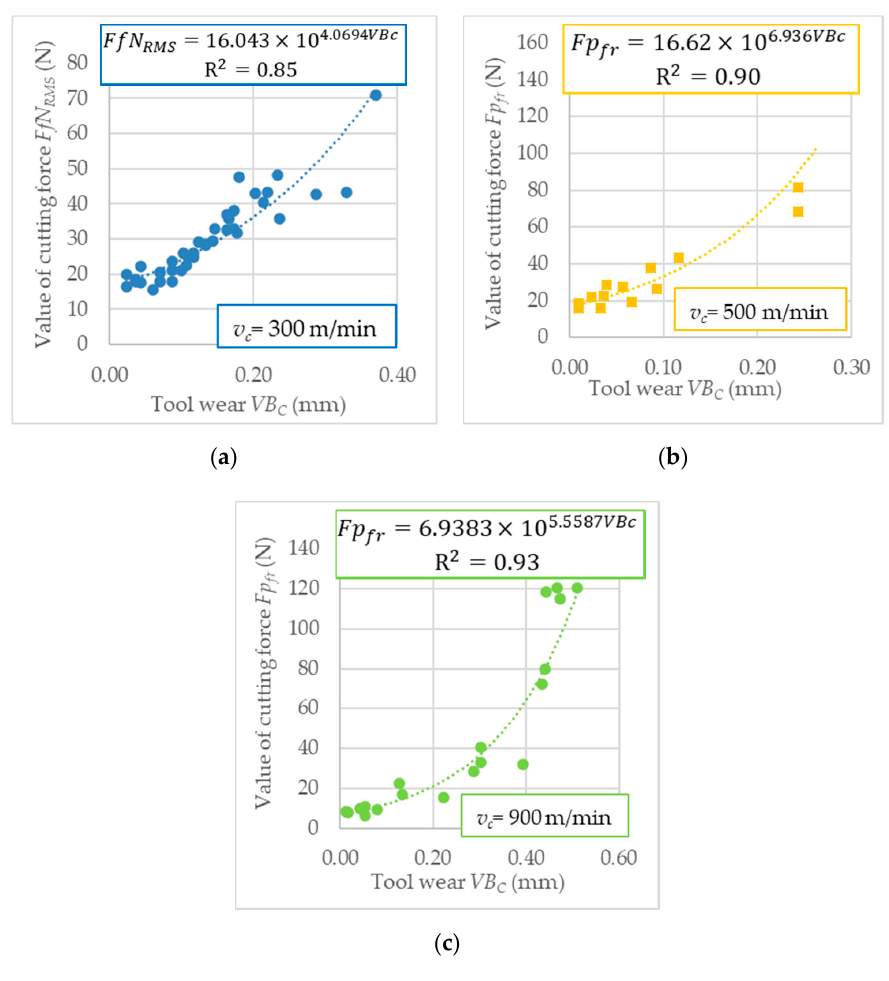
Figure 6. Diagnostic measures of cutting force components in ( a ) time domain, v c = 300 m/min; ( b ) Figure6. Diagnosticmeasuresofcuttingforcecomponentsin( a )timedomain, v c = 300m / min; ( b )frequency frequency domain, v c = 500 m/min; and ( c ) frequency domain, v c = 900 m/min; as a function of tool wear. domain, v c = 500 m / min; and ( c ) frequency domain, v c = 900 m / min; as a function of tool